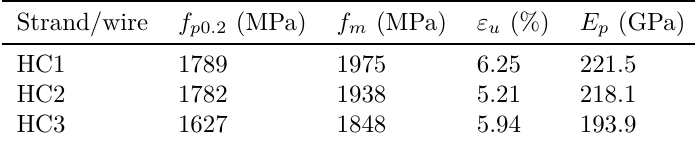
Table 2. Sample characteristics of material properties for prestressing